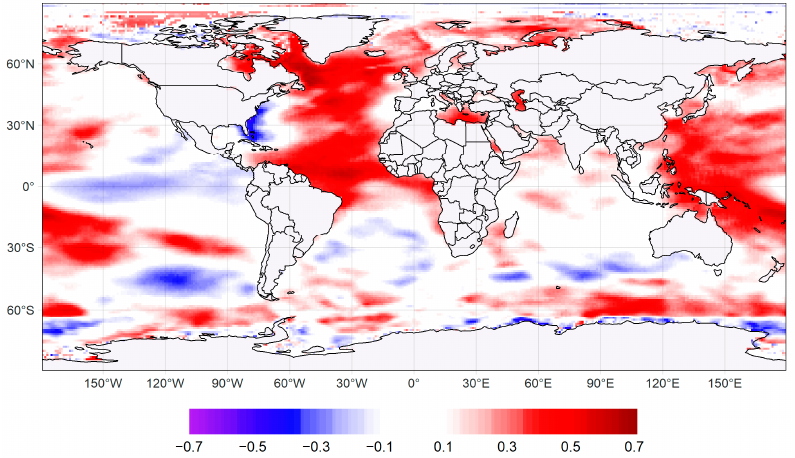
Figure 6. Spatial correlation between the annual number of ETCs and the annual mean SST.